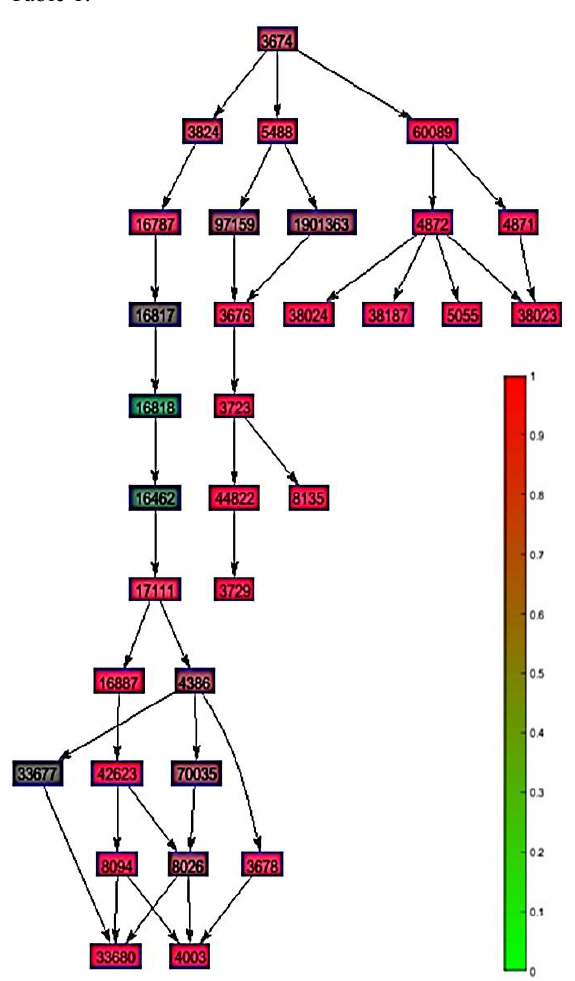
Figure 4. K-means clustering red and blue clusters Table 1. P-Value and Count of Annotated GO